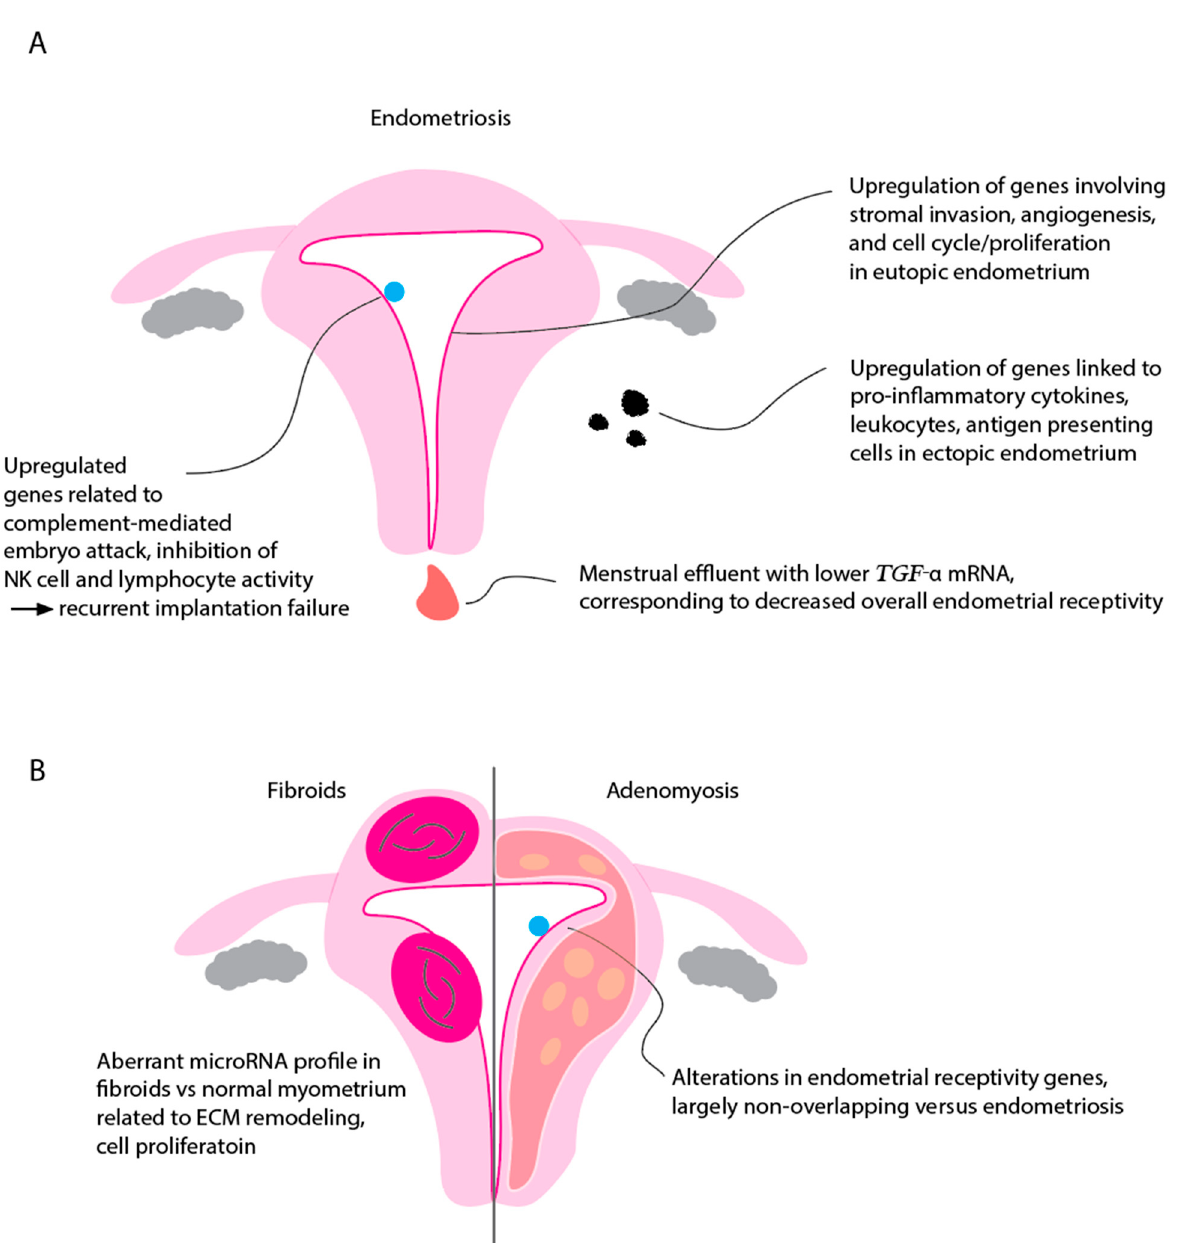
Figure 2. Transcriptomic changes in common benign gynecological disorders. ( A ) Alterations in gene expression in eutopic endometrium, ectopic endometrial implants (dark “powder burn” lesions for example), and menstrual effluent are displayed. ( B ) Changes in microRNA profiles in uterine fi broids, and changes in genes related to endometrial receptivity in adenomyosis are displayed.